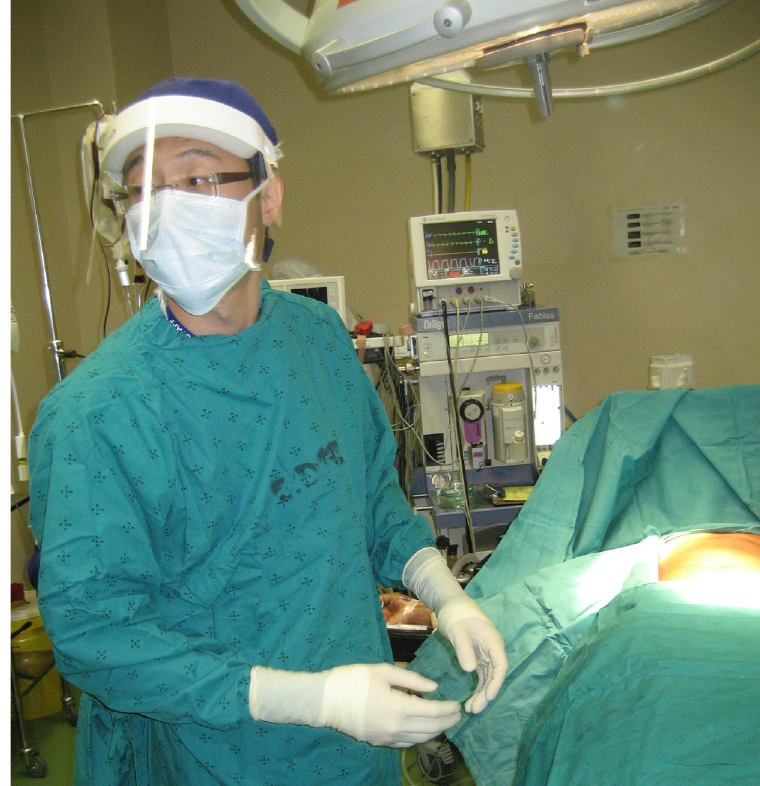
Figure 5. Me prior to performing a splenectomy (blunt trauma victum).